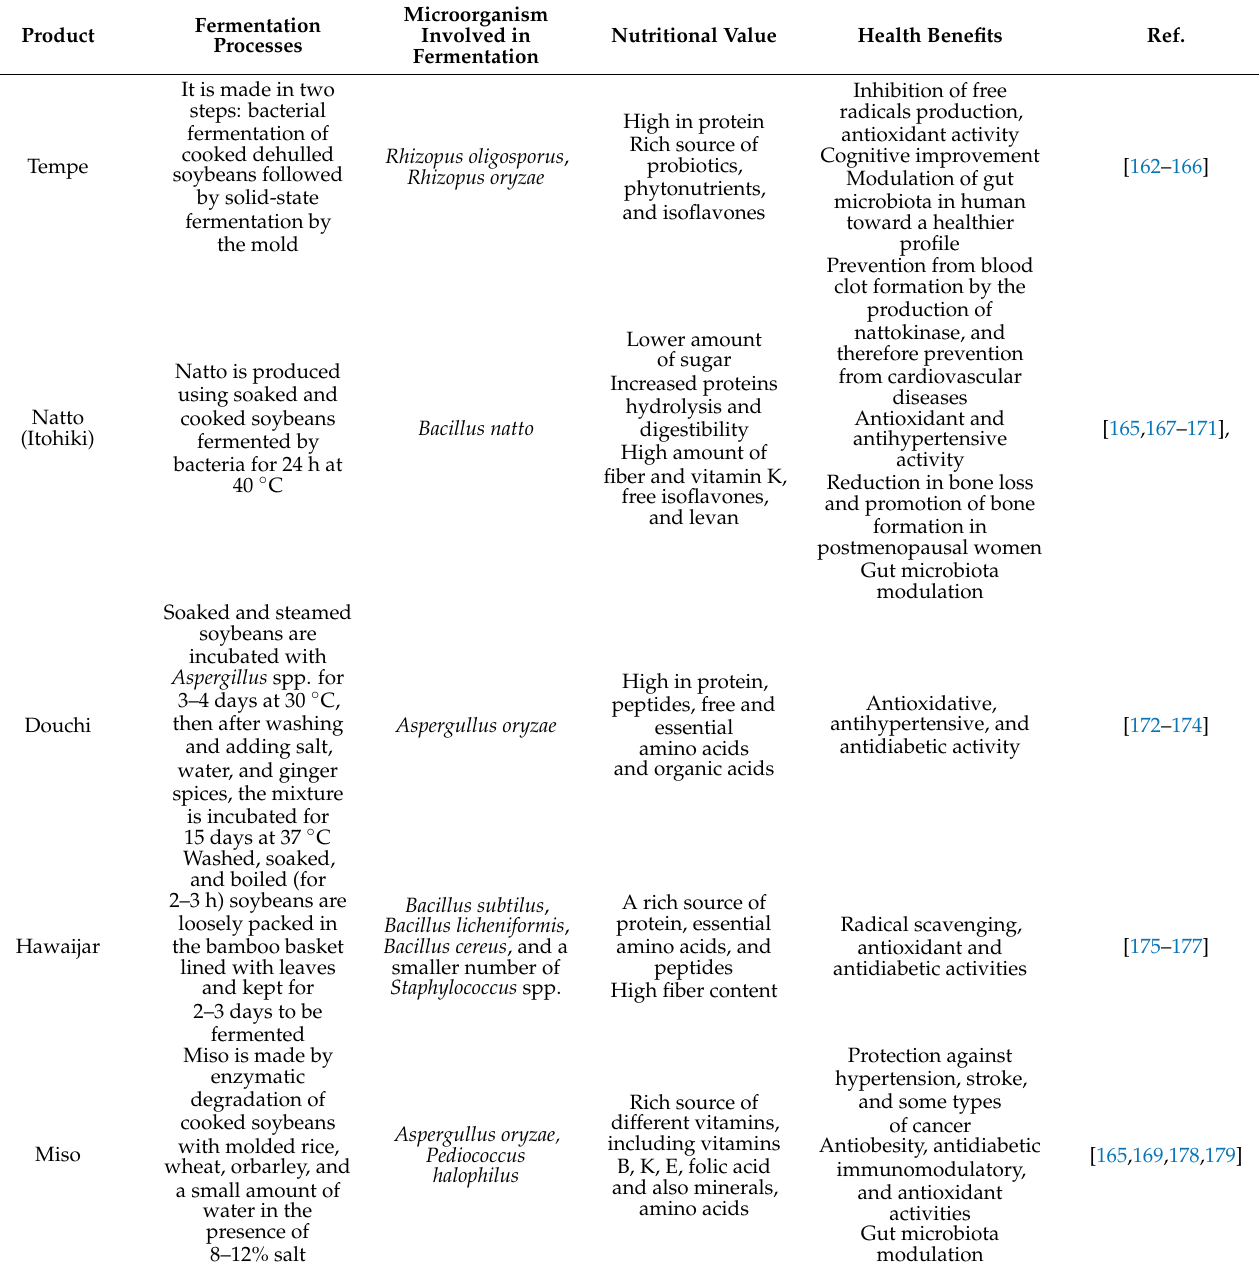
Table 1. The characteristics, nutritional value, and health benefits of fermented soy